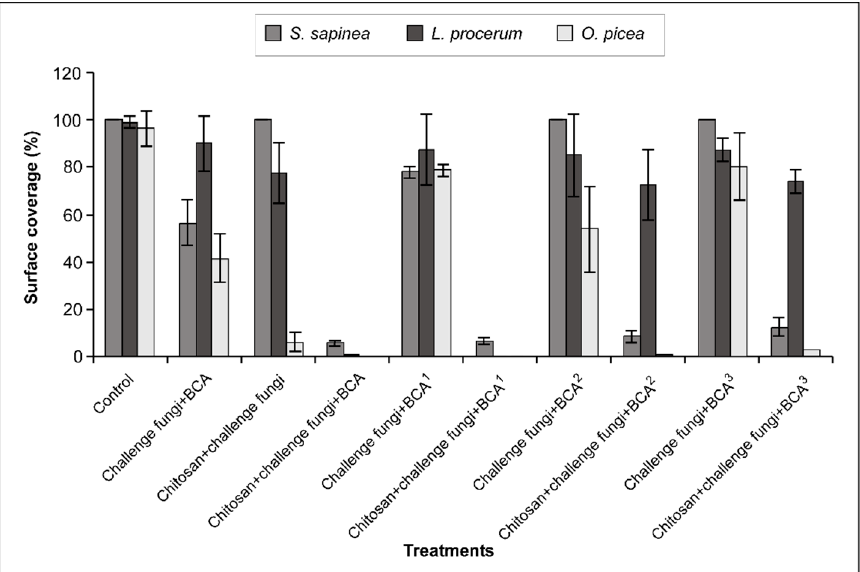
Figure 1. Surface coverage (%) of the sapstain fungal growth observed on radiata pine wood wafers after different treatments (n = 5). Error bars refer to standard error of means. Biological control agent (BCA) 1 — Trichoderma was inoculated after a one day delay; BCA 2 — Trichoderma was inoculated after a two day delay; BCA 3 — Trichoderma was inoculated after a three day delay).